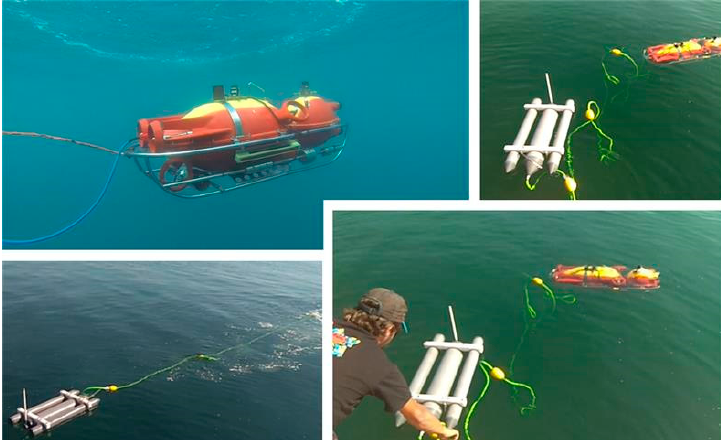
Figure 17. Deploying the platform to initiate the mission. AUV submarine connected to a buoy via a DSL cable.